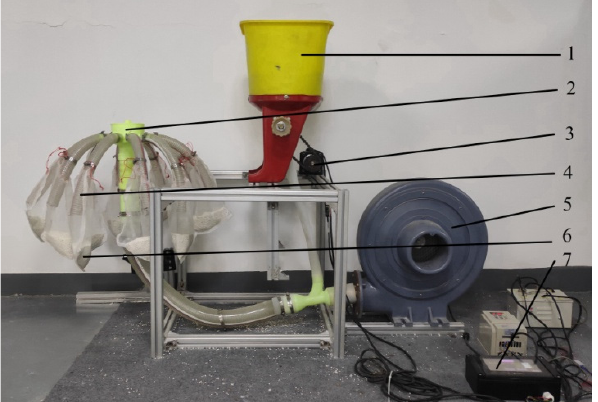
Figure 12. Pneumatic fertilizer discharge device bench. (1) fertilizer box, (2) distributor, (3) stepper motor, (4) fertilizer discharge tube, (5) centrifugal fan, (6) yarn bag, (7) test bench controller.